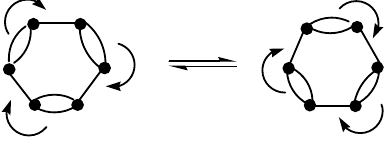
Figure 11. Dynamic resonance between two bent-bond Kekule formulae.